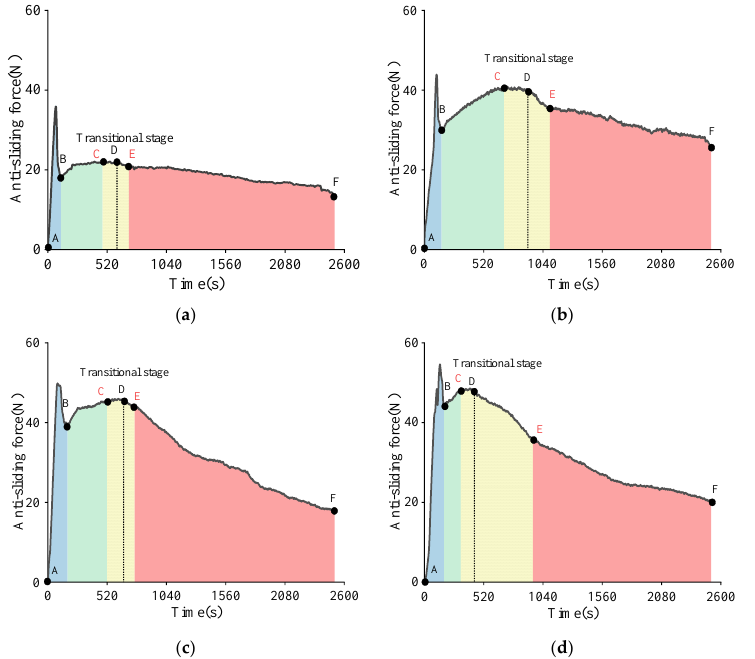
Figure 7. Stage division of anti-sliding force curve. ( a ) condition 1, ( b ) condition 2, ( c ) condition 3, ( d ) condition 4. The peak anti-sliding force of the 2.0 cm root length, 2.5 cm root length, and 3.0 cm root length increased by 20.84%, 37.70%, and 50.44%, respectively, when compared to the rootless support condition, and the corresponding peak time was delayed by 47.92%, 18.06%, and 89.58%, respectively. Secondary peak values for the 2.0 cm root length, 2.5 cm root length, and 3.0 cm root length were 40.85 N, 45.56 N, and 48.68 N, respectively, which were much higher than the 21.84 N without root support. Furthermore, after reaching the first peak, the degree of anti-sliding force attenuation with root support was greatly re- duced. After reaching the first peak, the anti-sliding force with 2.0 cm root length, 2.5 cm root length, and 3.0 cm root length support dropped to 66.64%, 78.35%, and 80.48%, re- spectively, while the anti-sliding force without root support dropped to 50.19% of the peak anti-sliding force (Figure 8).